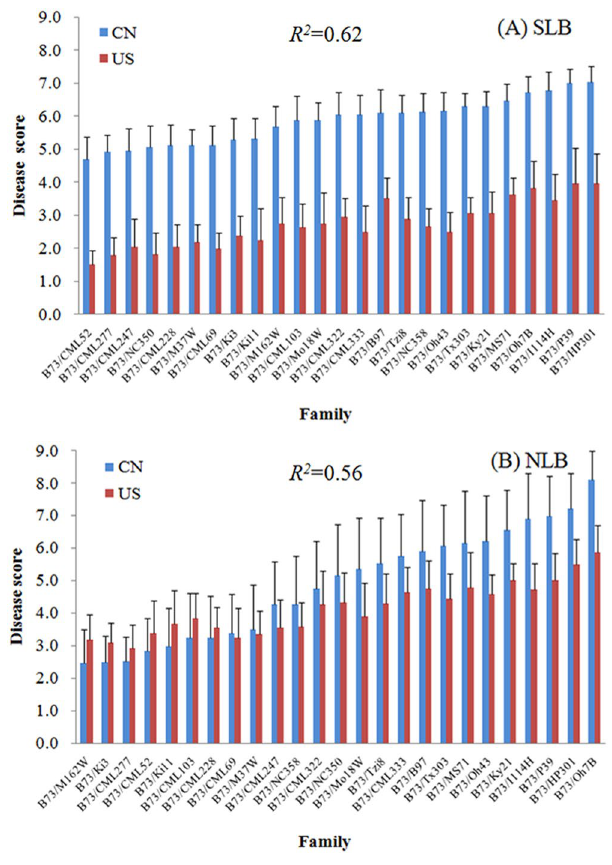
Figure 1. RIL family mean + St. Dev. of southern leaf blight (SLB) and northern leaf blight (NLB) disease scores in the United States (US) and China (CN). ( A ) SLB, and ( B ) NLB. Blue bars, the disease scores for the naturally inoculated conditions in China; red bars, the best linear unbiased predictions (BLUPs) of the disease scores in the US environments. The correlations ( R 2 ) were calculated using a linear model for all NAM RILs between the disease performance in the US and China.